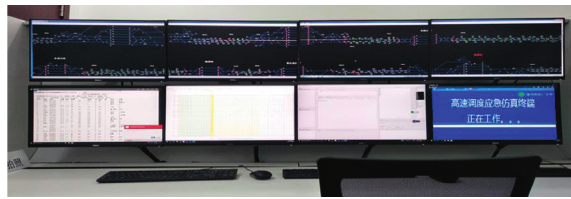
Figure 3: The dispatching